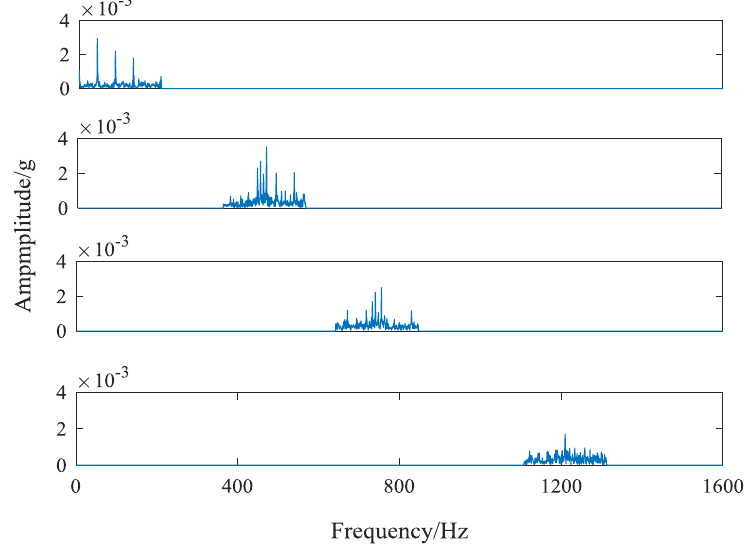
Figure 9. The feature frequency bands extraction based on original signal frequency spectrum.